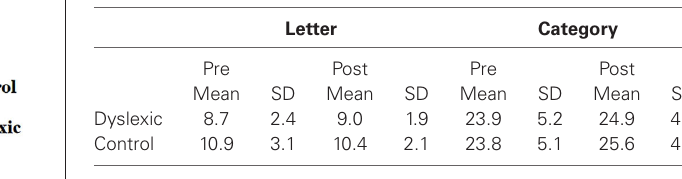
Table 1 | Mean scores of letter-based and category-based fluency tasks as a function group and training